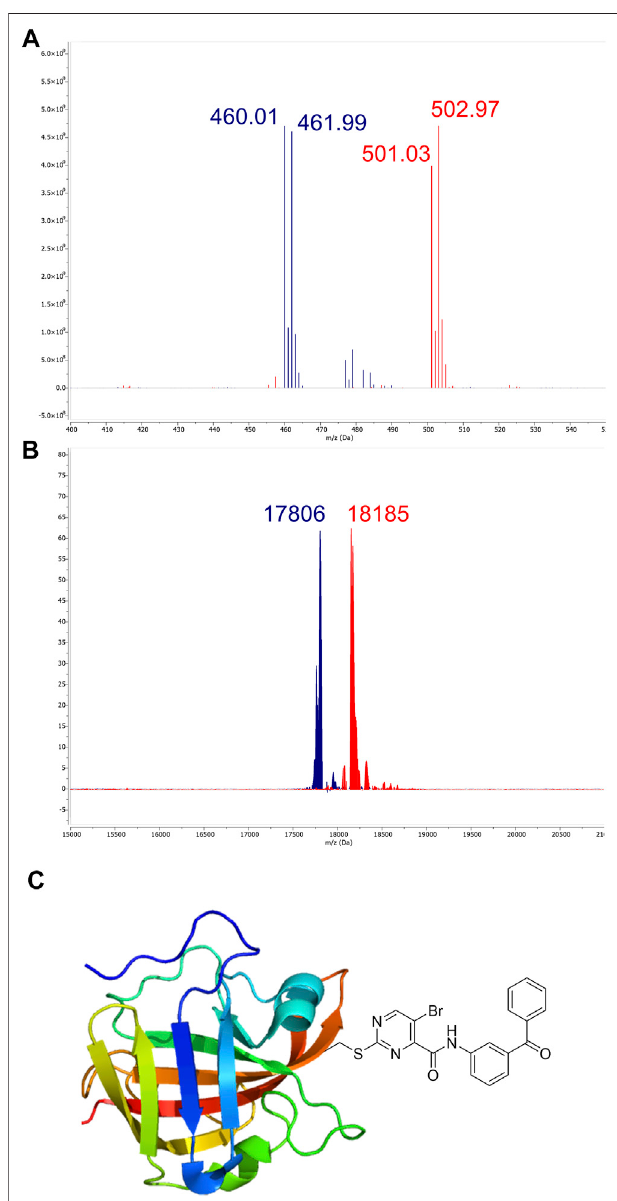
FIGURE5| Identi fi cationofcovalentadductsbymassspectrometry. (A) ESI-MS of compound 7a (blue, m/z (cid:1) 460.01) treated with free cysteine revealed the formation of a distinct adduct (red, m/z (cid:1) 501.03) corresponding to the respective 2-pyrimidyl cysteine (see the mechanism in Panel 1 ). (B) MALDI-TOF-MS of SrtA (blue, m/z (cid:1) 17,806) treated with compound 7a . The peak at m/z (cid:1) 18,185 (red) corresponds to the modi fi cation of the active site Cys 184 by compound 7a . (C) The predominant mode of SrtA inhibition is the transfer of the pyrimidyl-fragment to Cys 184 .